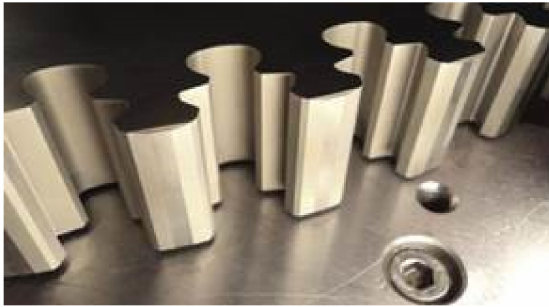
Figure 1. Example of geometry of a fir-tree